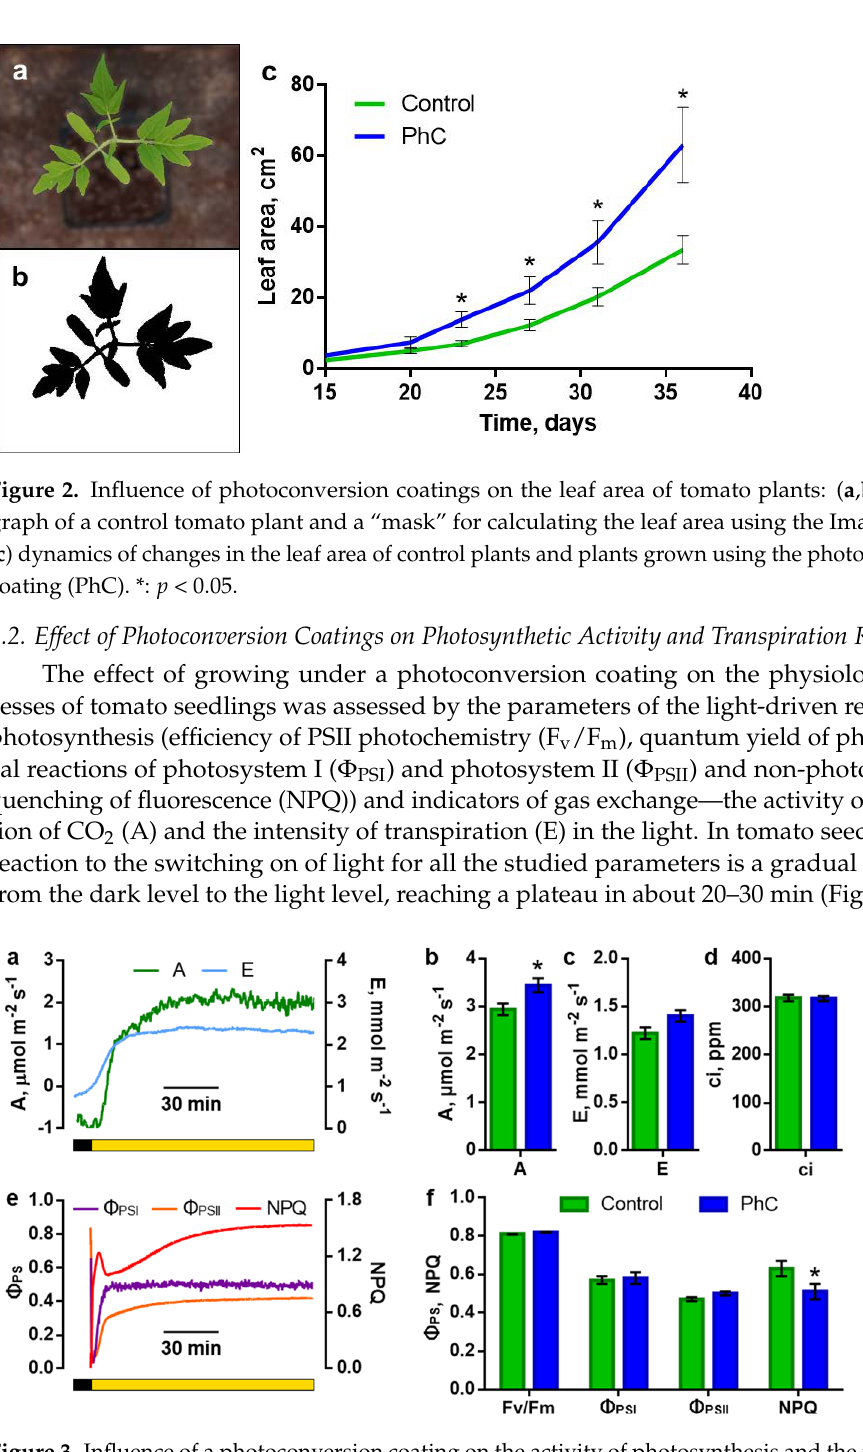
Figure 3. Influence of a photoconversion coating on the activity of photosynthesis and the intensity of transpiration of tomato plants: ( a ) a typical record of the responses of assimilation and transpiration of a control tomato plant to the switching on of the light; ( b – d ) the effect of the photoconversion coating on the level of assimilation, the intensity of transpiration and intercellular CO 2 concentration; ( e ) a typical record of the light-driven reactions of photosynthesis of a control tomato plant to light switching on; ( f ) the effect of the photoconversion coating on the light-driven reactions of photosynthesis. A: assimilation of CO 2 ; E: transpiration; ci: intercellular CO 2 concentration; F v /F m : efficiency of PSII photochemistry; Φ PSI and Φ PSII : quantum yield of photochemical reactions of photosystems I and II; NPQ: non-photochemical quenching of fluorescence; PhC: photoconversion. *: p < 0.05.